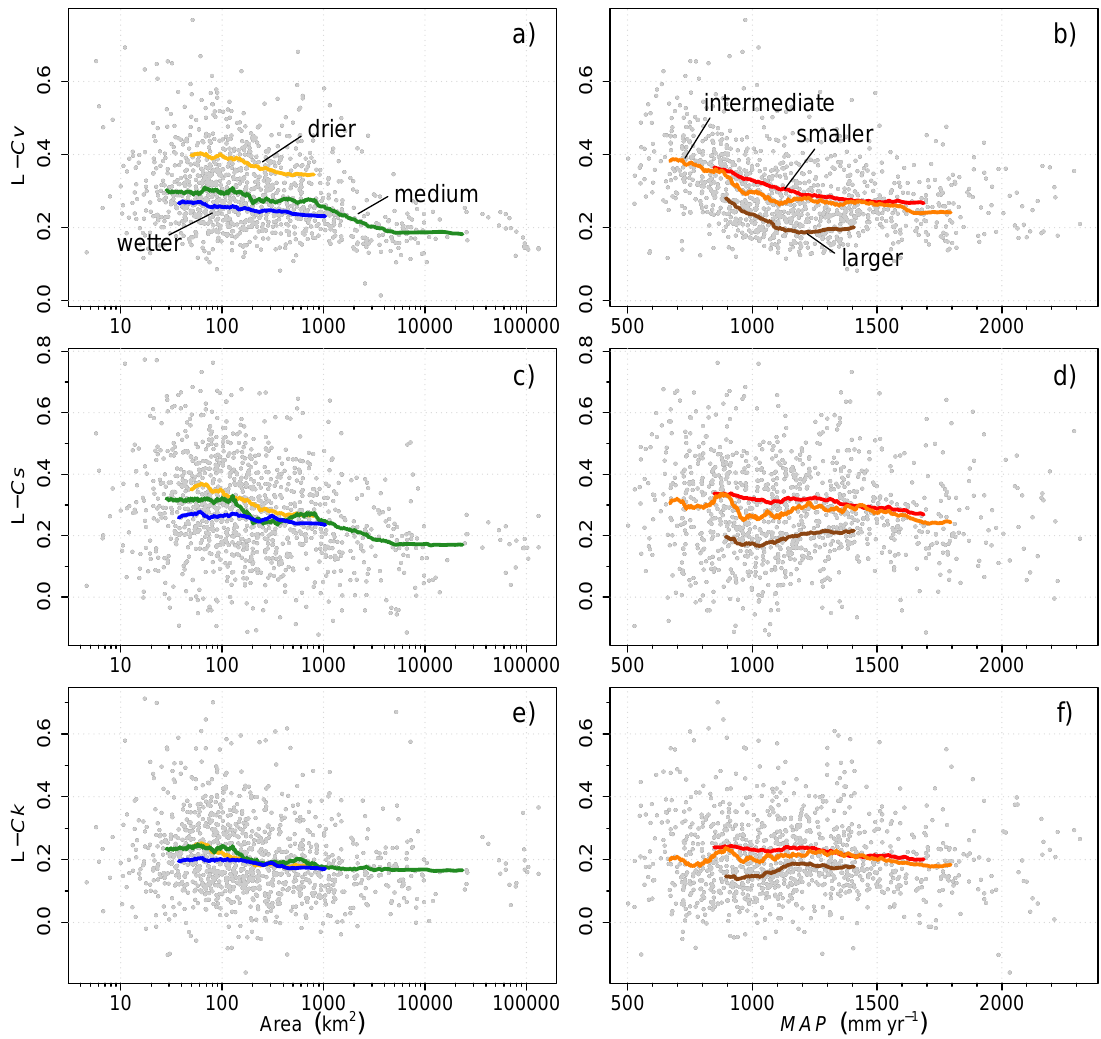
Figure 3. Sample L-Cv, L-Cs and L-Ck values for each catchment (grey points) plotted against catchment area and MAP. Lines show the record length WMAs over 70 catchments for the subsets smaller, intermediate, larger, drier, medium, and wetter defined in Fig.